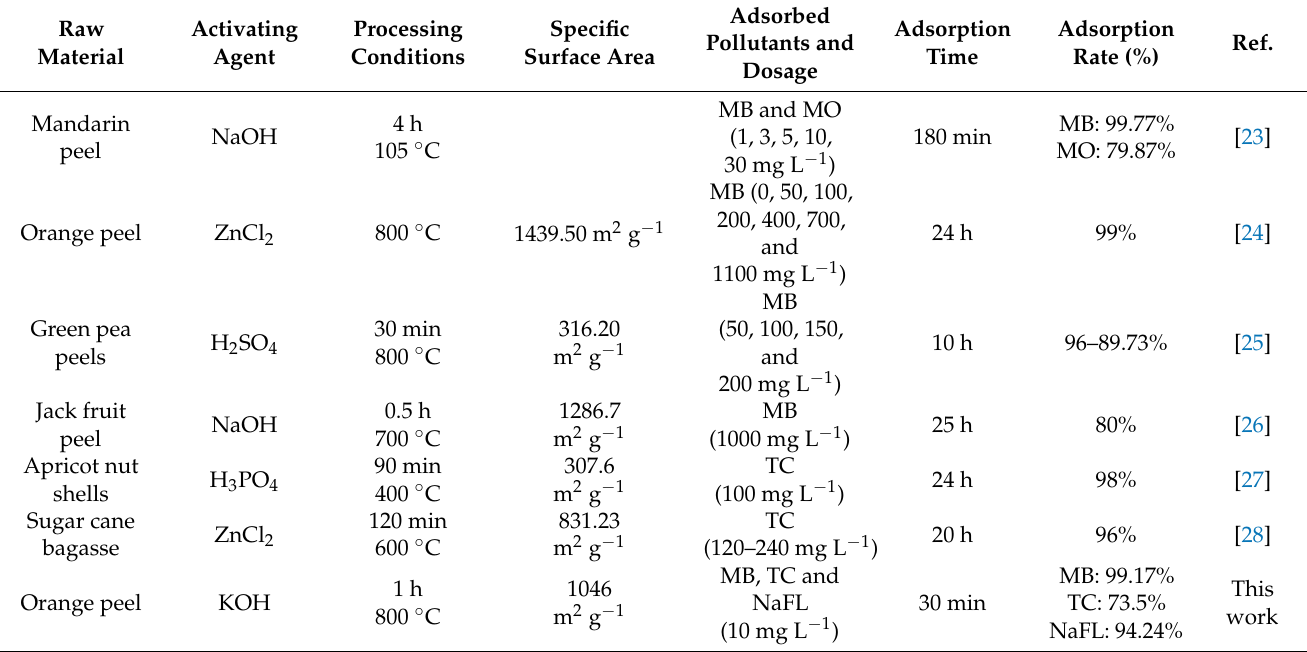
Table 4. Comparison of adsorption properties of biomass-based activated carbon reported in